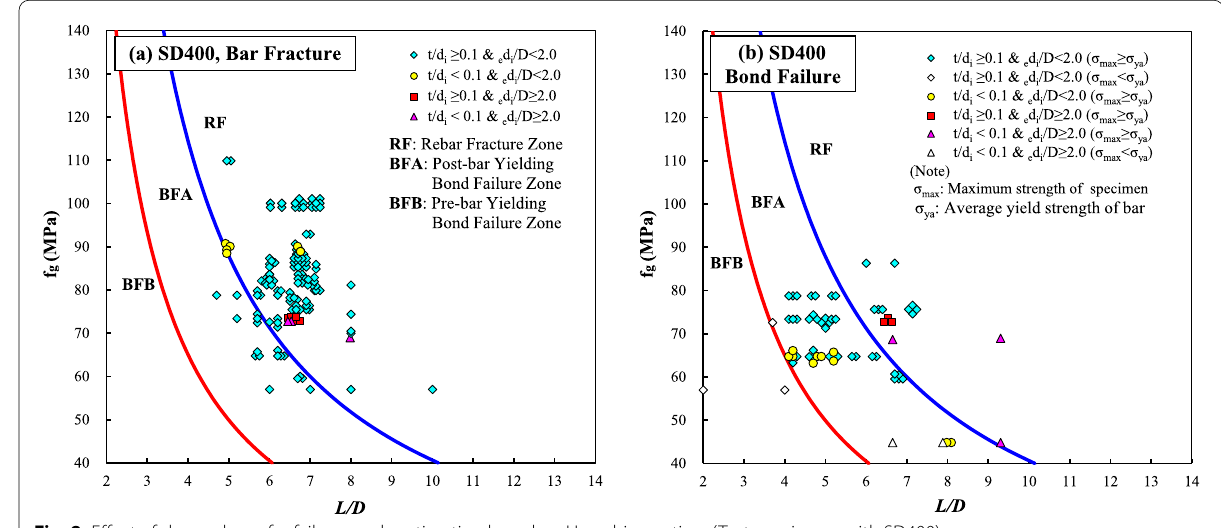
Fig. 8 Effect of sleeve shape for failure mode estimation based on Hayashi equation. (Test specimens with